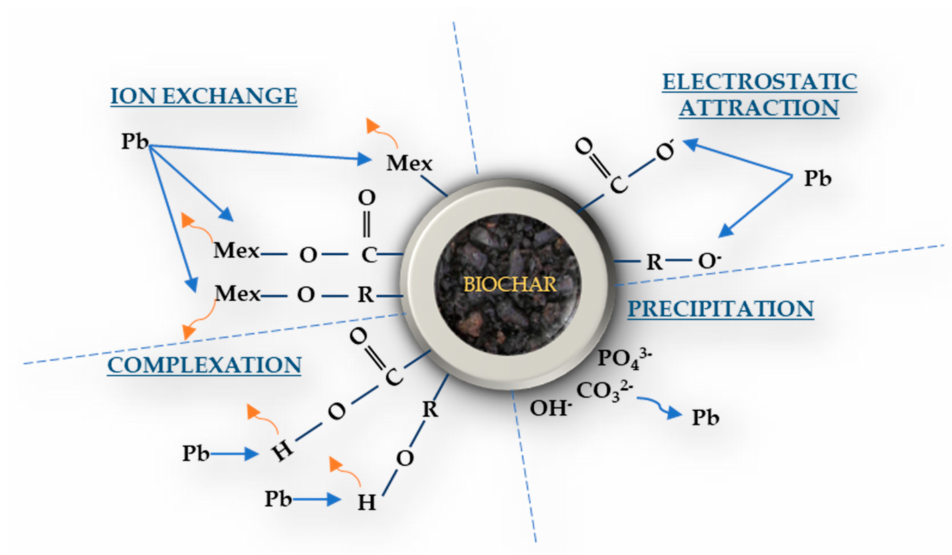
Figure 4. Potential mechanisms of biochar interactions with cationic PTEs in soil. The example of lead (Pb), Mex: exchangeable ions (Mg 2+ , Ca 2+ etc.) (modified from